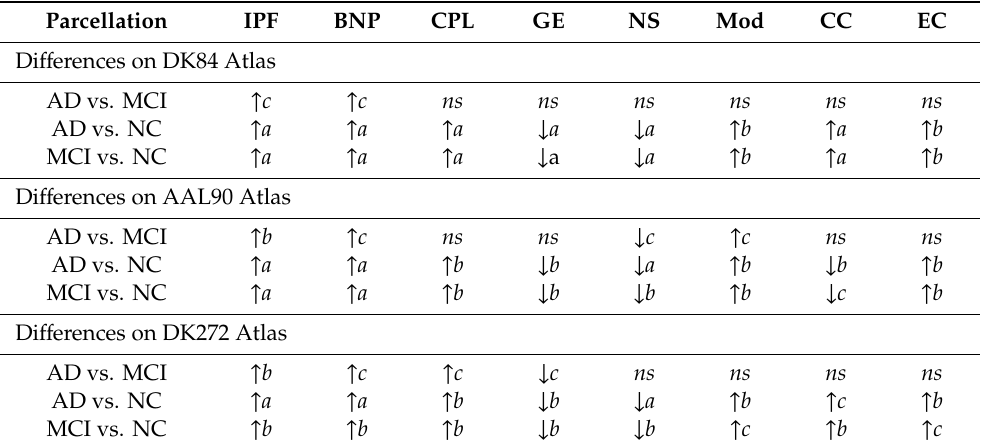
Table 3. Resulting p -values of di ff erences across three groups validated by three parcellations. Parcellation